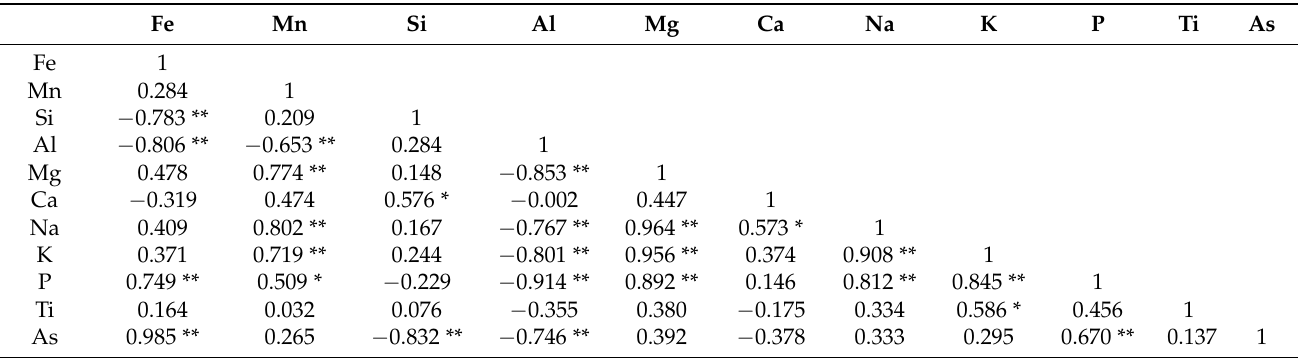
Table 2. Correlation matrix showing the coefficients for the different elements in the FMNs ( n = 16).